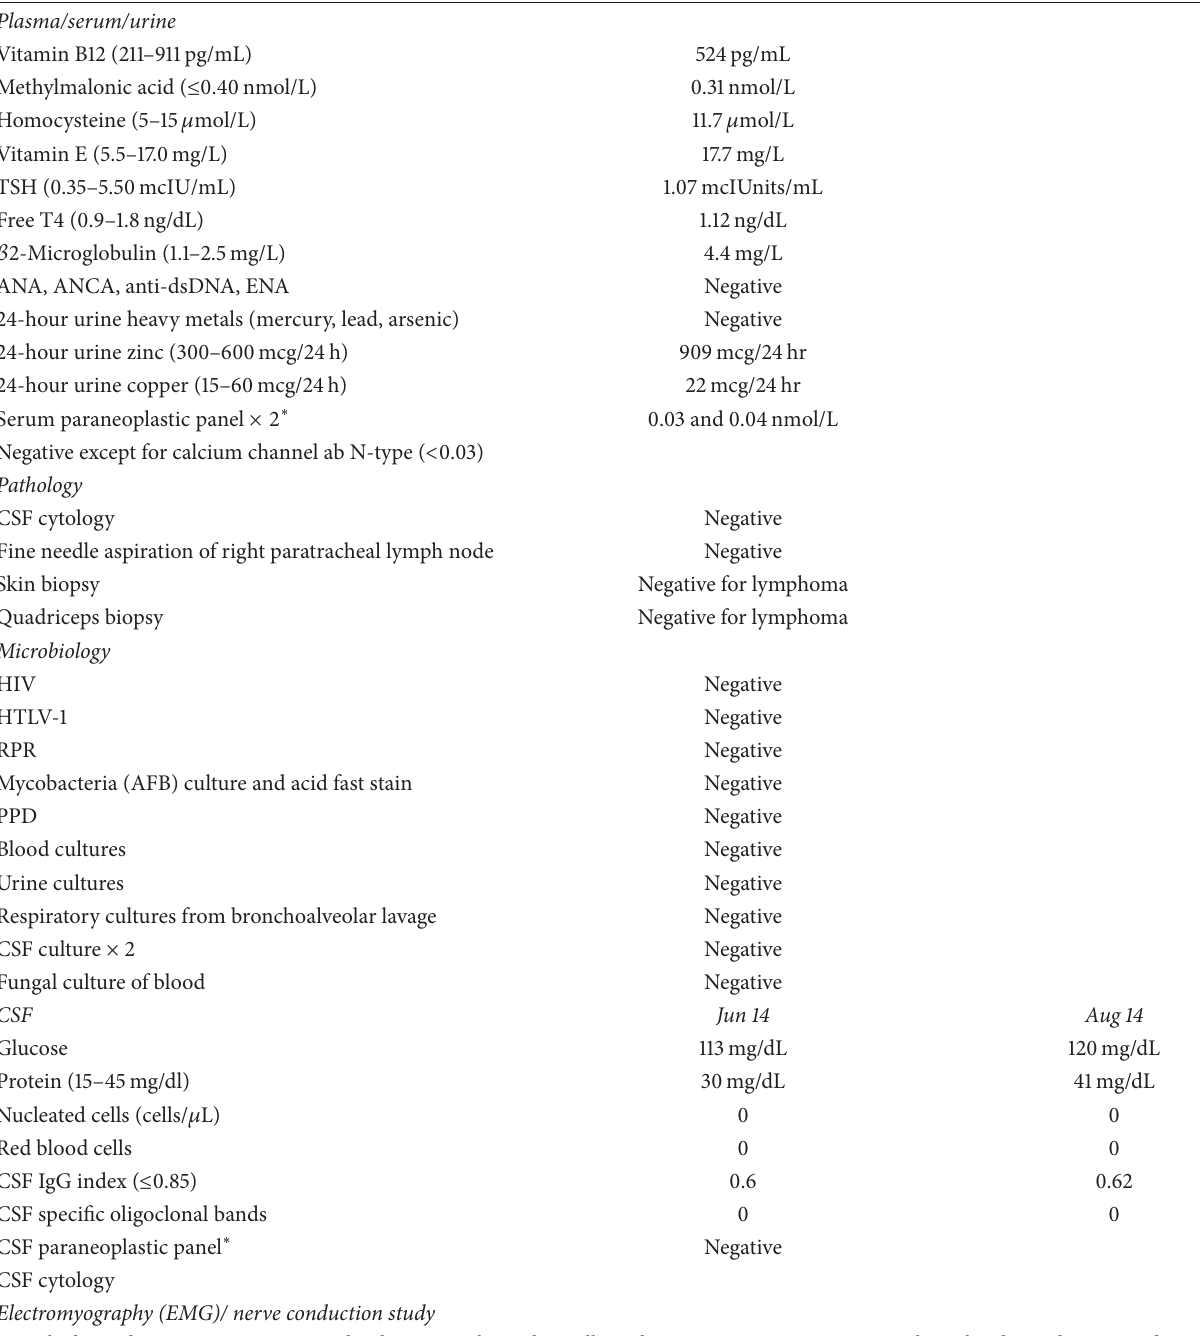
Table 1: Relevant